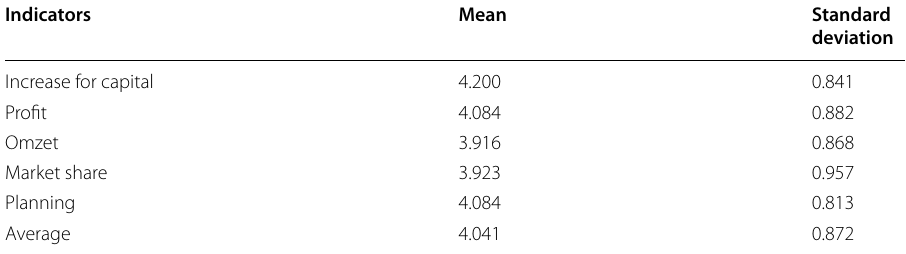
Table 6 Mean score business success in